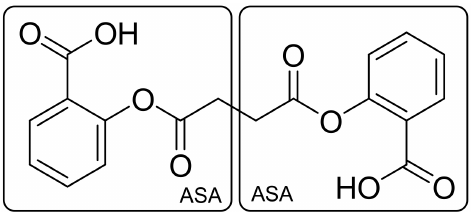
Figure 5. Aspirin—homodimer.